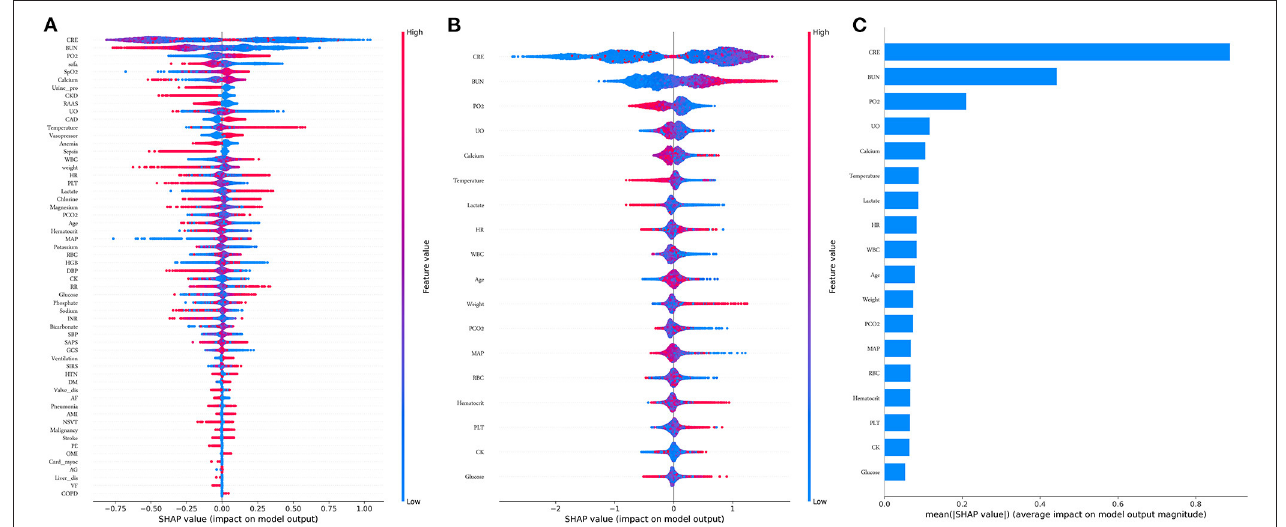
FIGURE 3 | Features importance estimated using the Shapley Additive explanations (SHAP) values. (A) All 58 features, the blue to red color represents the feature value (red high, blue low). The x-axis measures the impacts on the model output (right positive, left negative); (B) Compact 18 features; (C) Significance of the predictors in the LightGBM model. CRE, creatinine; BUN, blood urea nitrogen; PO2, partial pressure of oxygen; UO, urine output; HR, heat rate; WBC, white blood cell; PCO2, partial pressure of carbon dioxygen; MAP, mean aortic pressure. RBC, red blood cell; PLT, platelet; CK, creatine